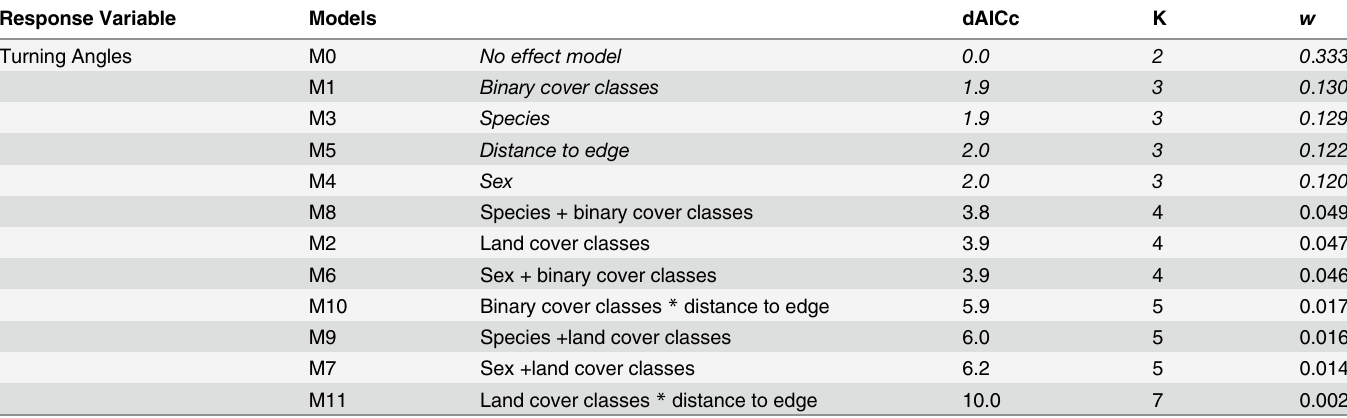
Table 2. Competing models using turning angles for the trajectories for Turdus leucomelas and T . rufiventris . Plausible model in italic. K is the num- ber of estimated parameters and the w Akaike weights (relative likelihood of the model) and the w is the Akaike weights (relative likelihood of the model). Response